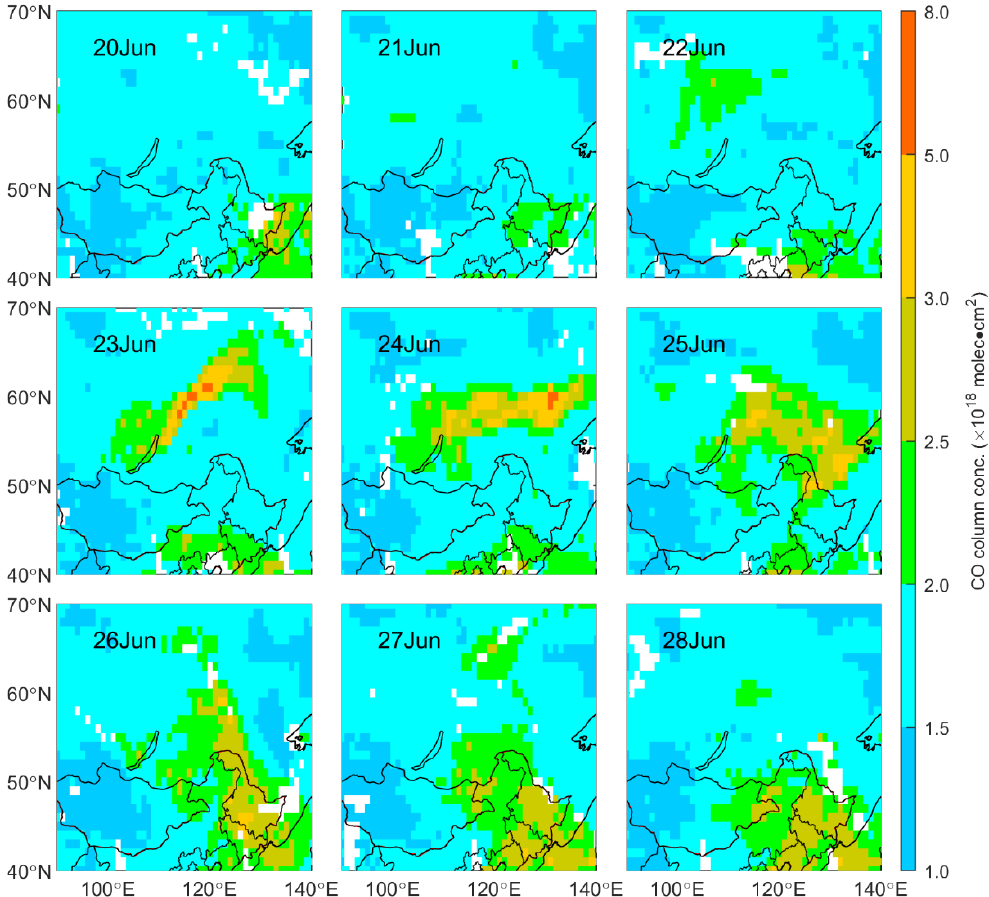
Figure 5. Spatial distribution of CO total column concentration (unit: molec·cm 2 ) from 20 June to 28 June 2017 in Northeast Asia.